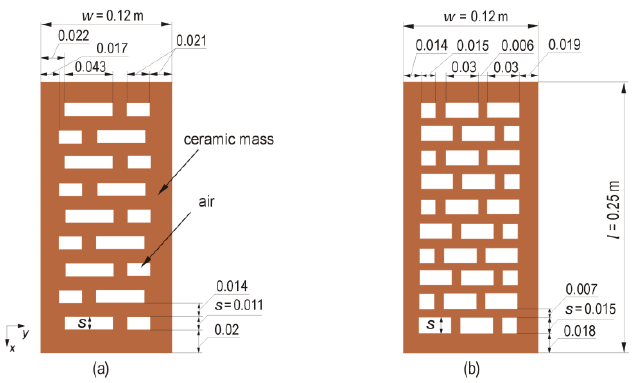
Figure 1. Geometric dimensions of the analyzed hollow bricks (two-dimensional (2D) view in the XY plane): ( a ) with 18 holes (B18), ( b ) with 30 holes (B30).